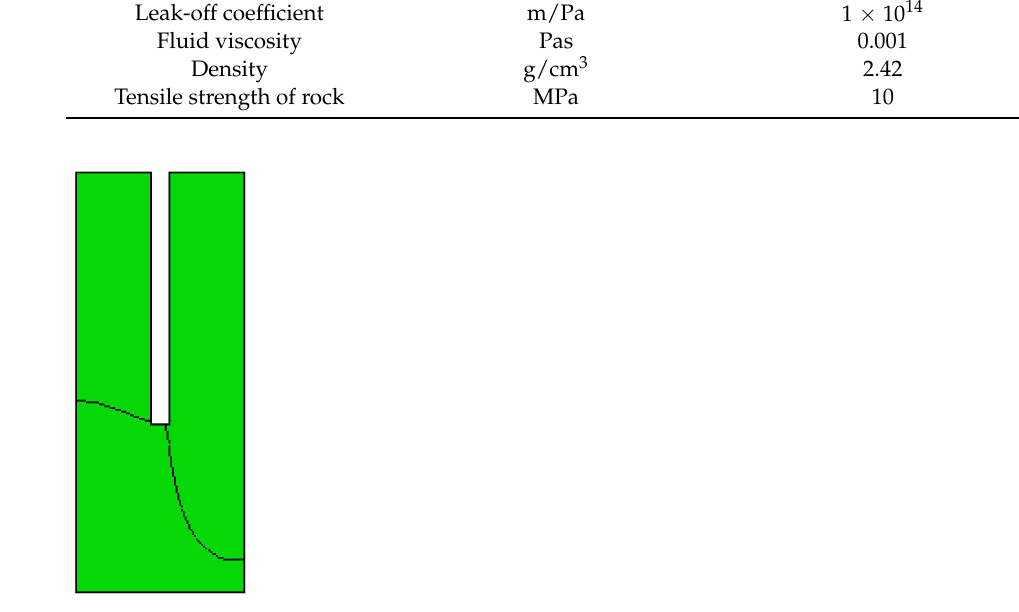
Figure 8. Fracture geometry at the end of simulation.